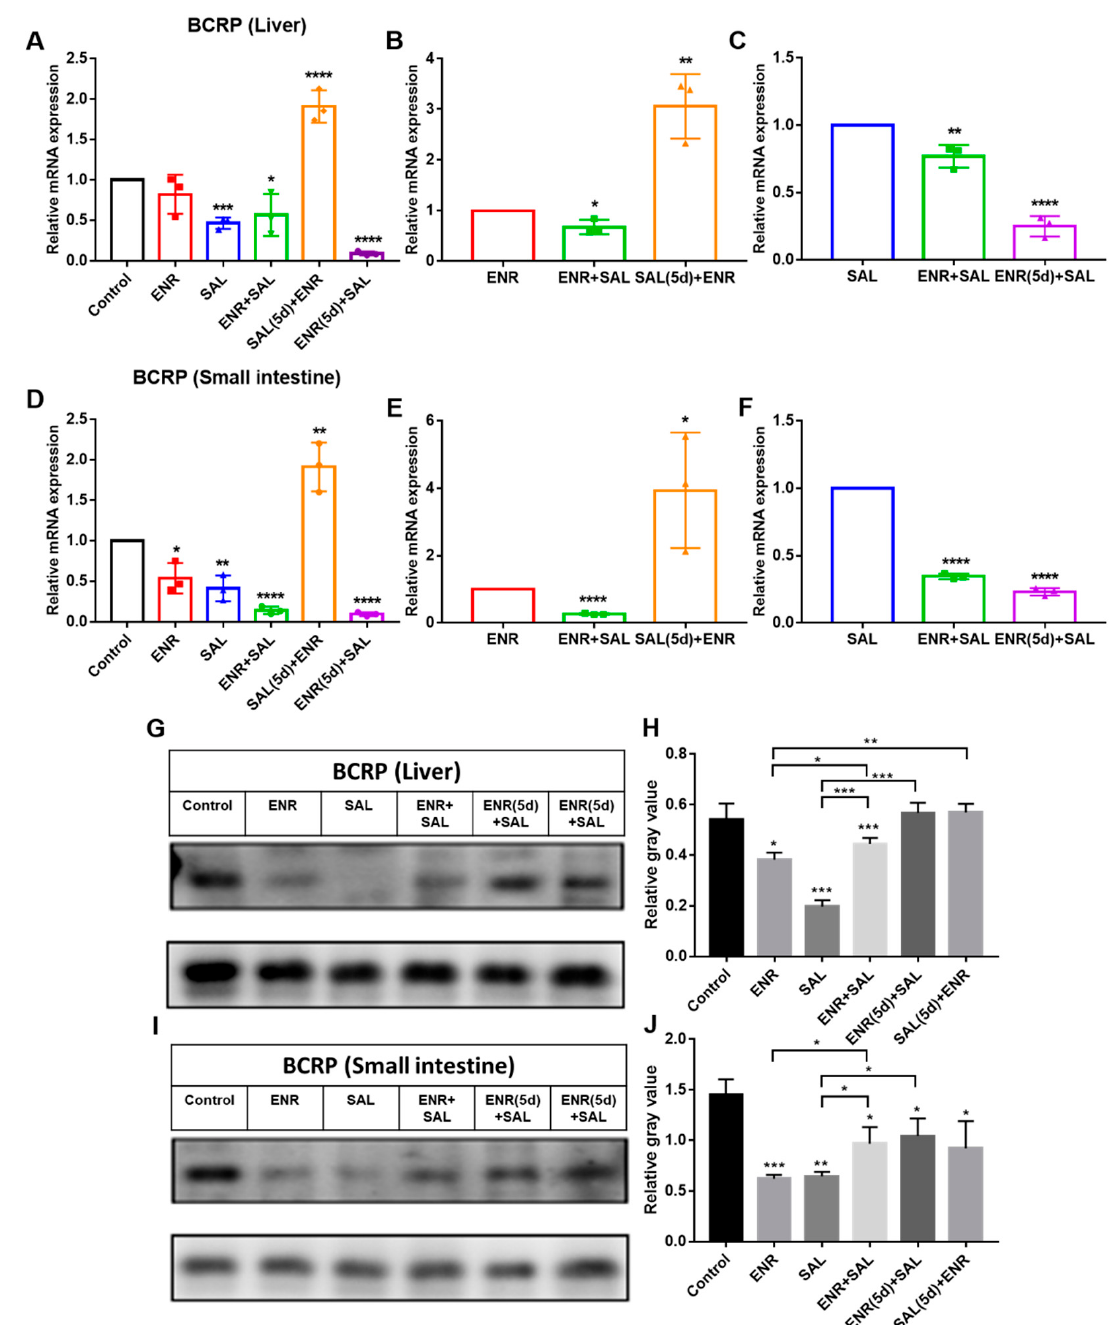
Figure 6. Effects of ENR and SAL on BCRP gene expression levels in liver and small intestine. ( A – C ) are expression in liver, ( D – F ) are expression in small intestine. ( B , E ) are the effects of single ENR as control group, single combined administration group (ENR + SAL) and continuous 5d SAL group (SAL (5d) + ENR) on the expression level of BCRP. ( G , I ) are protein expression in liver and small intestine, respectively. ( H , J ) are gray value levels of figure ( G ) and ( I ), respectively. ( C , F ) are the effects of single SAL as control group, single combined administration group (ENR + SAL) and continuous 5d ENR group (ENR (5d) + SAL) on the expression level of BCRP. * on the error bar of each group indicates the difference from the control group. * means p < 0.05; ** means p < 0.01; *** means p < 0.005; **** means p < 0.001. The effects of the ENR + SAL group and SAL (5d) + ENR group on BCRP gene levels were consistent with the results on P-gp (Figure 6B,E). Compared with the single